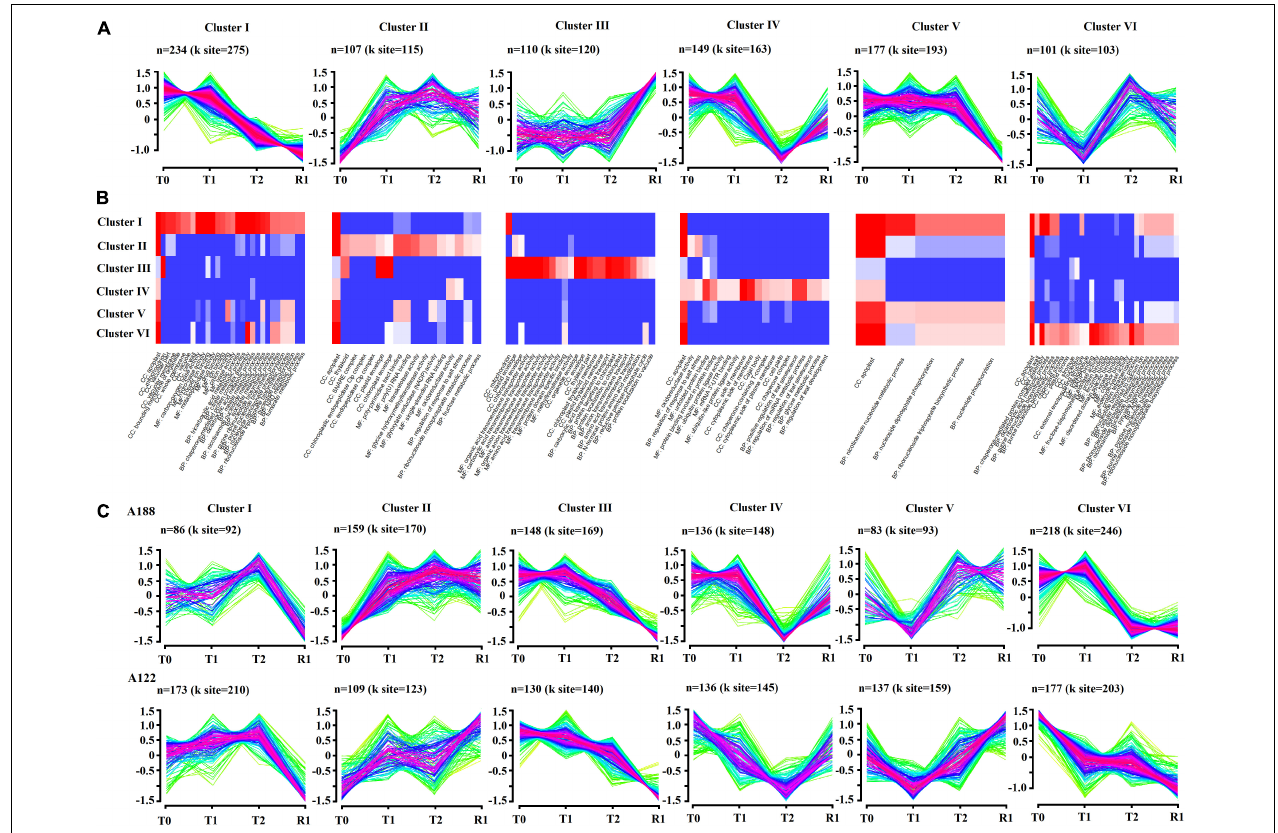
FIGURE 7 | Dynamic acetylome remodeling of peppers during cold stress and recovery stages. (A) Unsupervised clustering of acetylome dynamics revealed top six clusters with distinct protein expression profiles. n represents the number of acetylated proteins per cluster. (B) Gene ontology enrichment analysis of each cluster. Representative biological process (BP), cellular components (CC), and molecular function (MF) that are overrepresented in one of the clusters are visualized. (C) Unsupervised clustering of acetylome dynamics revealed top six clusters with distinct protein expression profiles in A188 and A122, respectively. n represents the number of acetylated proteins per